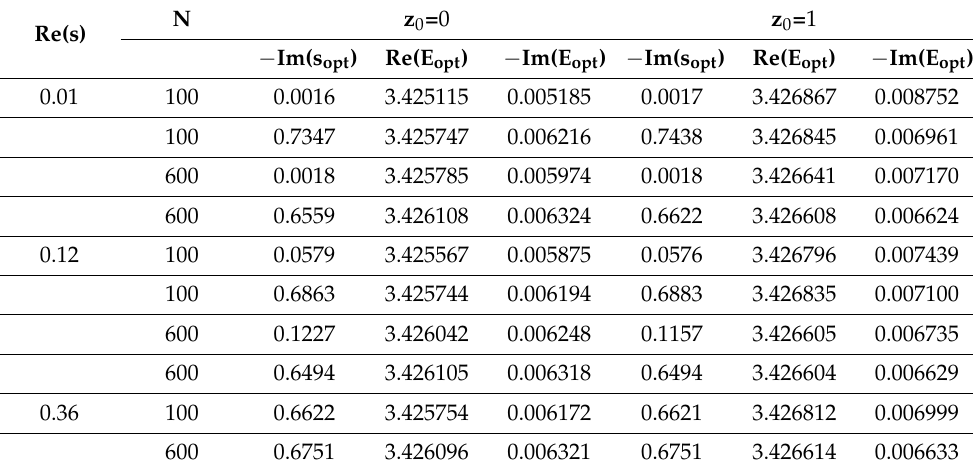
Figure 5. Trajectories (with z 0 = 0) in the case ζ = λ = 0.36 for the problem I (solid line), problem II (dashed lines), and problem III (dash-dotted lines). Calculations were carried out for various values of N, i.e., ○ —N = 100, □—N = 600. Signs + and x indicate the position of the resonance and optimal point, respectively. Data are presented in a.u. Table 2. Optimal trajectory points (problem II). All the data are presented in